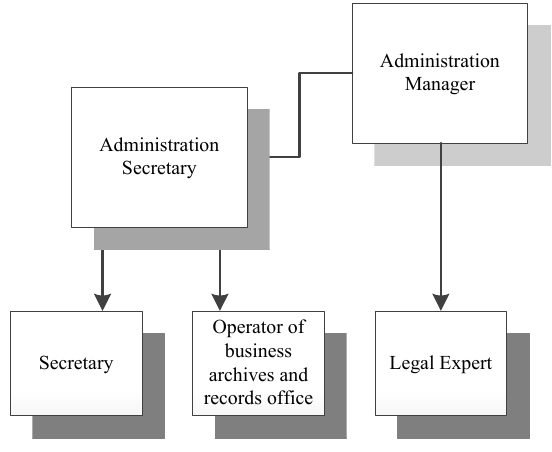
Figure 3. Organogram of the case study